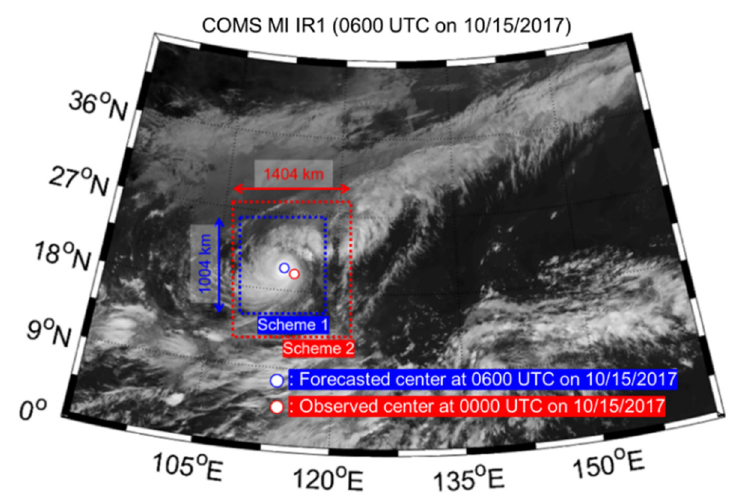
Figure 3. Examples of interest regions according to the two schemes using Communication, Ocean and Meteorological Satellite Meteorological Imager observations at 0600 UTC on 15 October 2017. The blue circle is the tropical cyclone center predicted from Korea Metrological Association forecasting reports at 0600 UTC on 15 October 2017 issued 6 h prior, and the red circle is the tropical cyclone center observed at 0000 UTC on 15 October 2017. The blue and red dashed boxes are the interest regions used for schemes 1 and 2 , respectively.